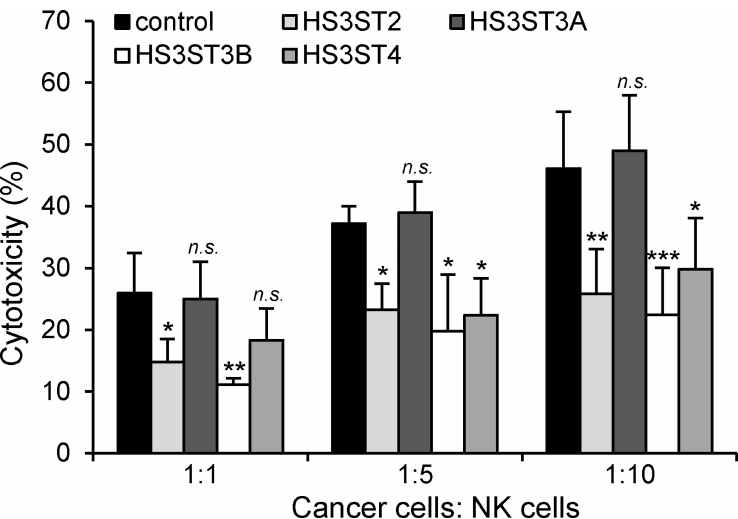
Fig 6. Effects of the expression of HS3STs on NK-mediated cell death. Control or HS3ST-overexpressing MDA-MB-231 cells were cultured for 32 h and then exposed to activated NK cells for 5 h at the different ratios target/ effector 1:1, 1:5 and 1:10. NK-mediated cytotoxicity was estimated by using a LDH assay, as described in “Materials and Methods”. Data are means ± S.D. from three separate experiments performed with NK cells from distinct